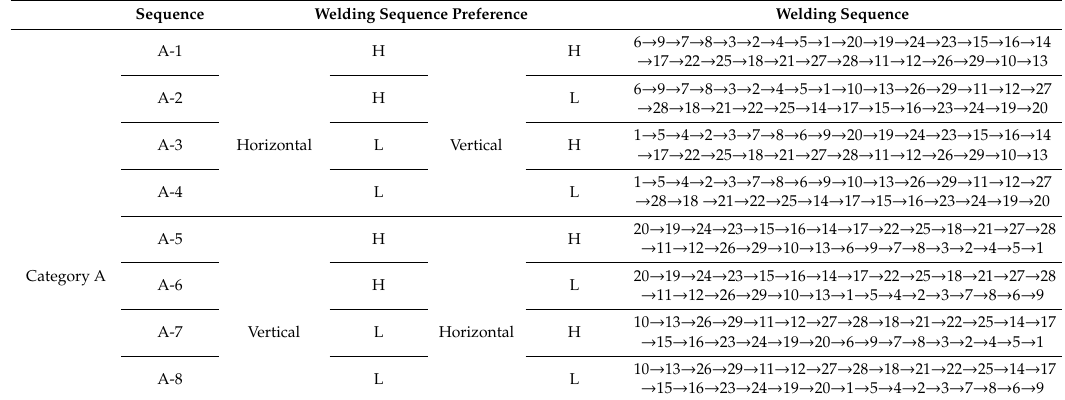
Table 3. Welding sequences of Category A.